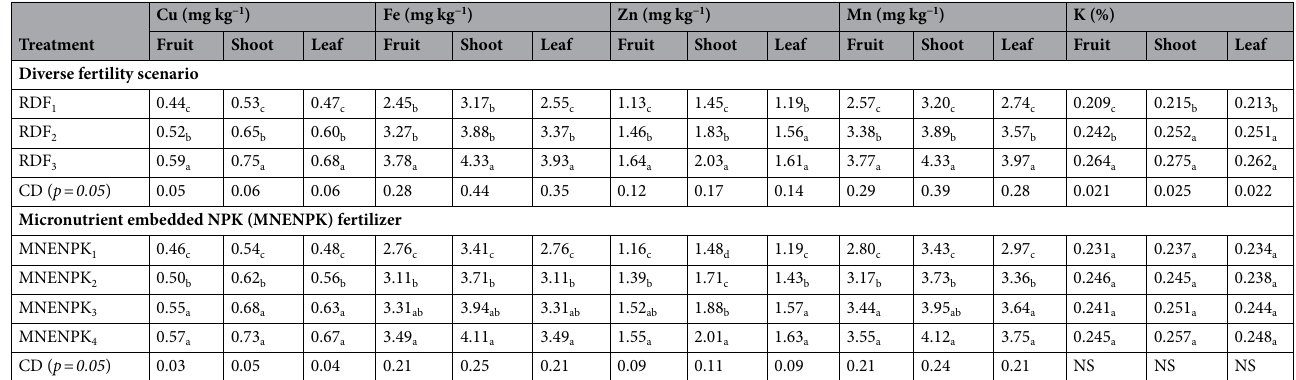
Table 3. Effect of diverse fertility scenarios and multi-micronutrient foliar fertilization on nutrient concentrations in eggplant fruit, shoots and leaves. Means followed by a similar lowercase letter within a column are not significantly different at p < 0.05 according to Tukey’s HSD test; data are pooled means of 2017–2018 and 2018–2019 cropping